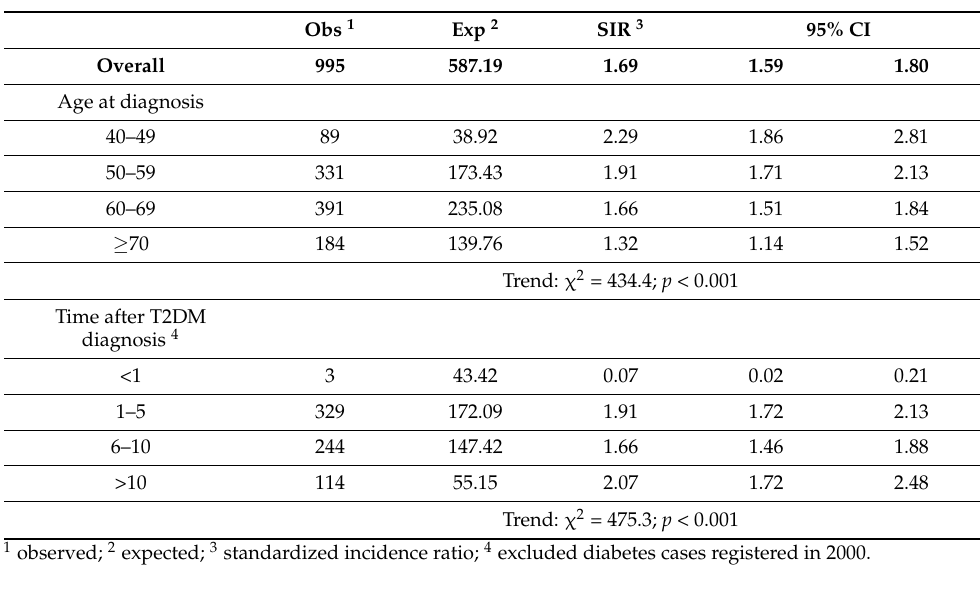
Table 1. EC risk by age and time after diagnosis among women with T2DM in Lithuania.